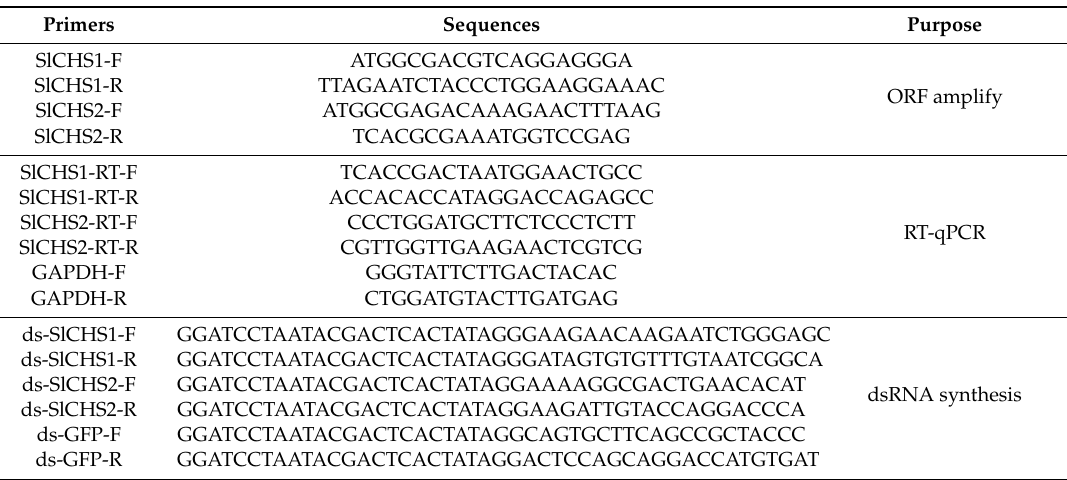
Table 1. Primers used in this